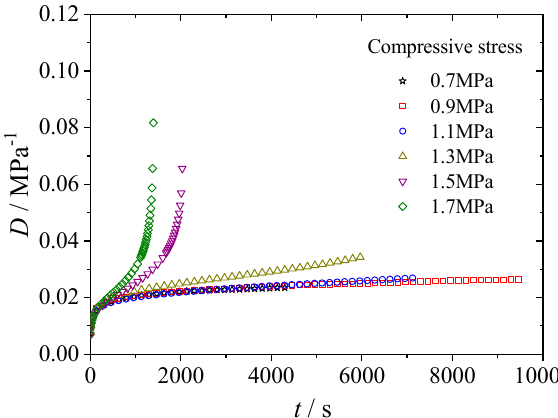
Figure 8. Creep compliance curves of asphalt mixture under various compressive stress levels.